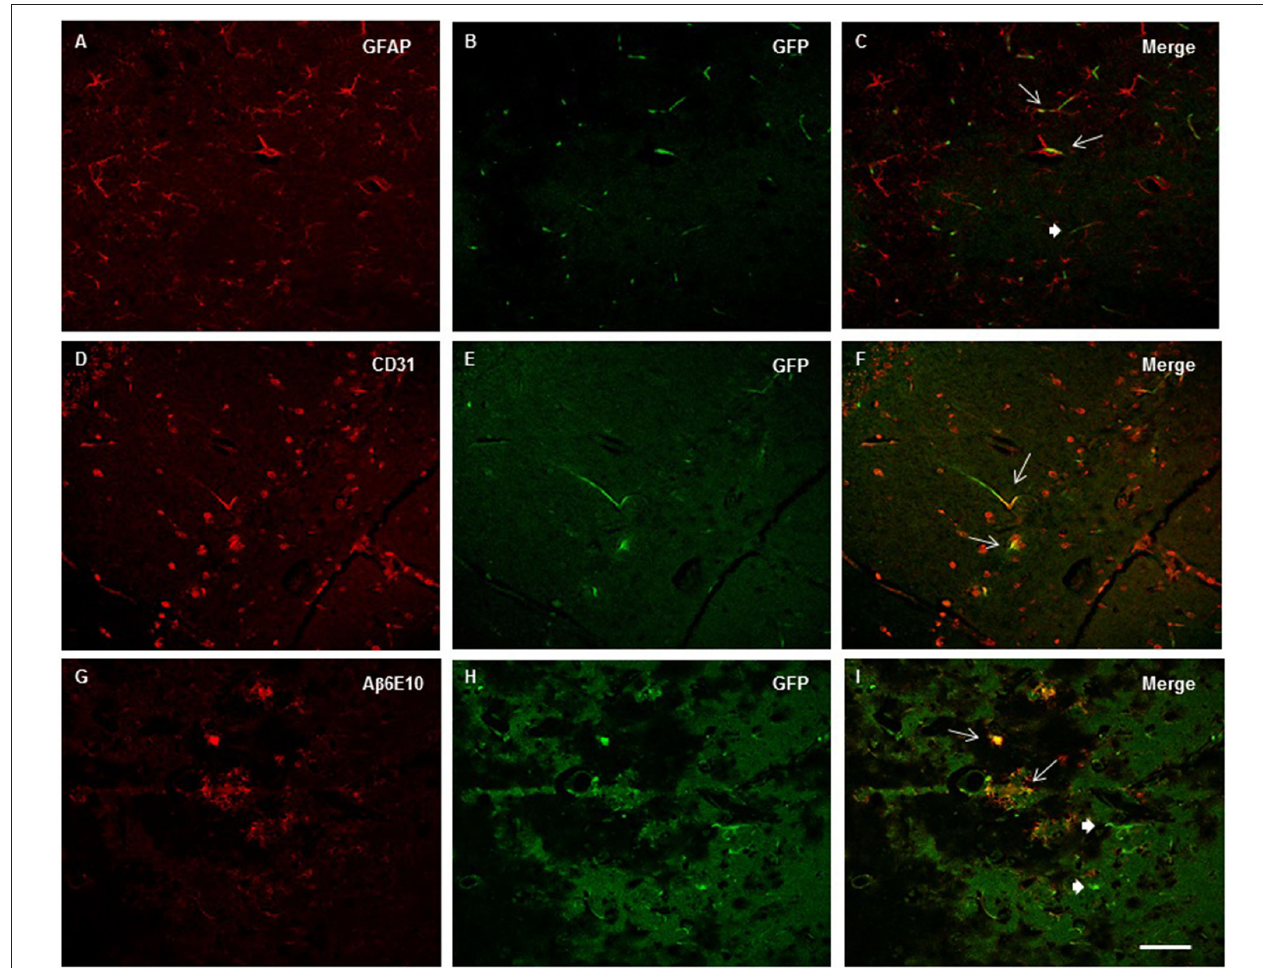
FIGURE 8 | Images from confocal microscopy reveled GFP + Mesenchymal stem cells (MSC)- Vascular endothelial growth factor (VEGF) cells in the cortex (A–C) and hippocampus (D–I) . Double labeling of GFP and GFAP